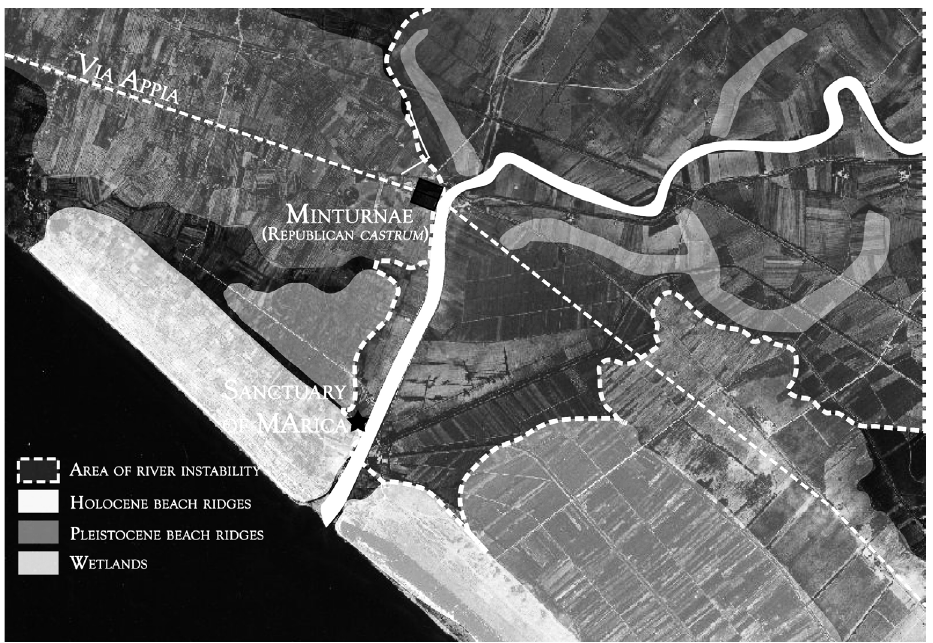
Figure 7: Geomorphology of the Garigliano river delta plain near Minturnae